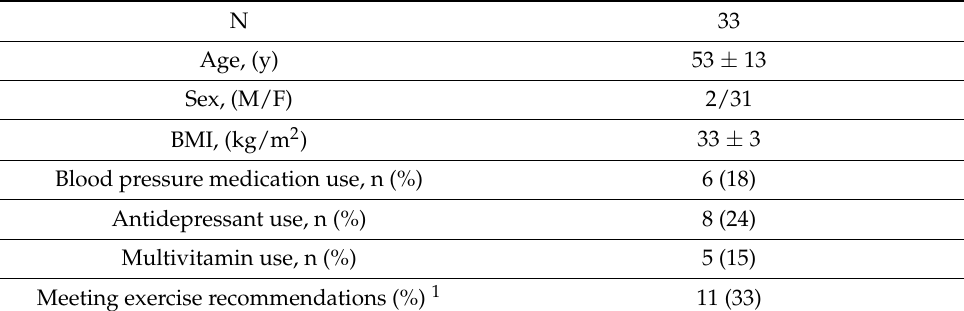
Table 2. Baseline characteristics of study